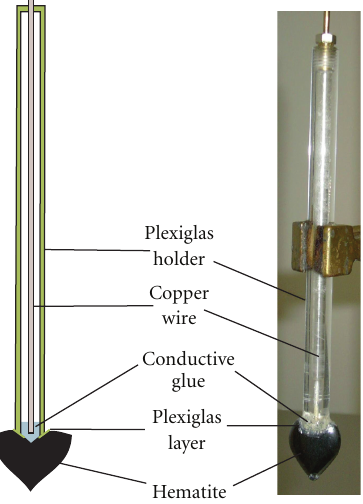
Figure 2: Nonporous polycrystalline hematite electrode.